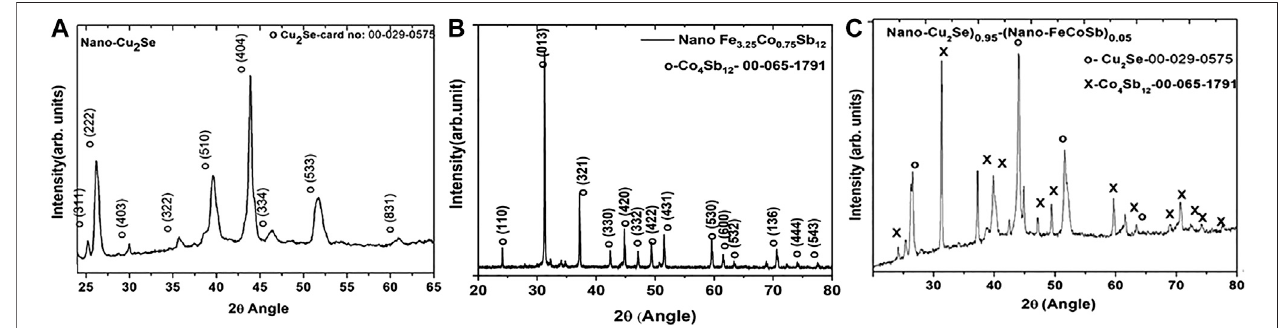
FIGURE 2 | Fractural nano-Cu